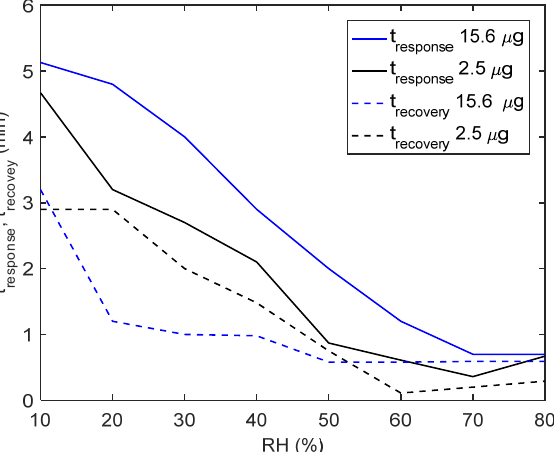
Figure 9. The response (t response ) and recovery times (t recovery ) of the frequency shift measured with staircase experiments shown in Figure 8b.